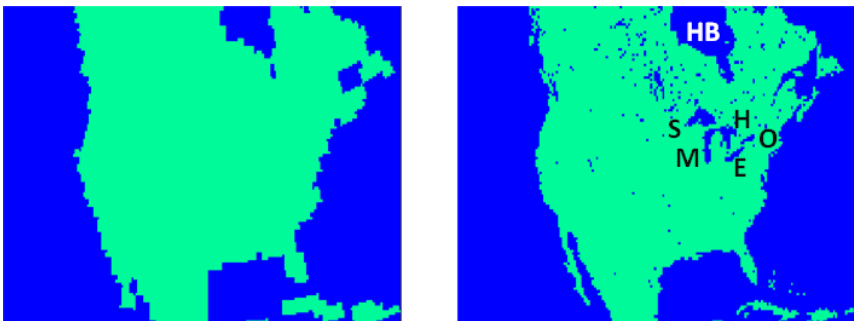
Figure 1. The ocean mask from the 1 ◦ CESM data (which is used by WPS to determine the locations of land and water points from CESM), as shown in the area corresponding to a WRF 36km continental US domain (left), and the 36km WRF grid’s land–water mask (right). Labels are placed to indicate the locations of Lake Superior (“S”), Lake Michigan (“M”), Lake Huron (“H”), Lake Erie (“E”) and Lake Ontario (“O”), as well as Hudson Bay (“HB”).